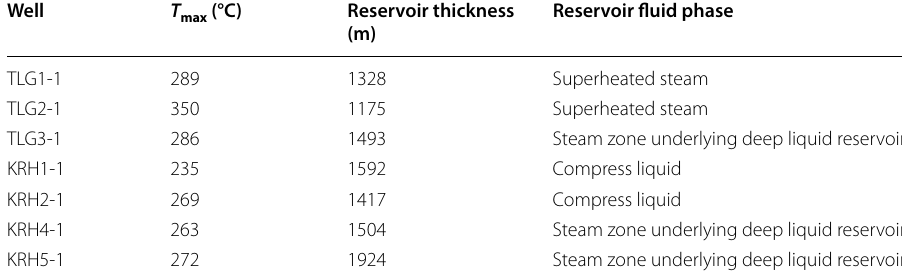
Table 2 The characterization of seven wells in K–TB field Well